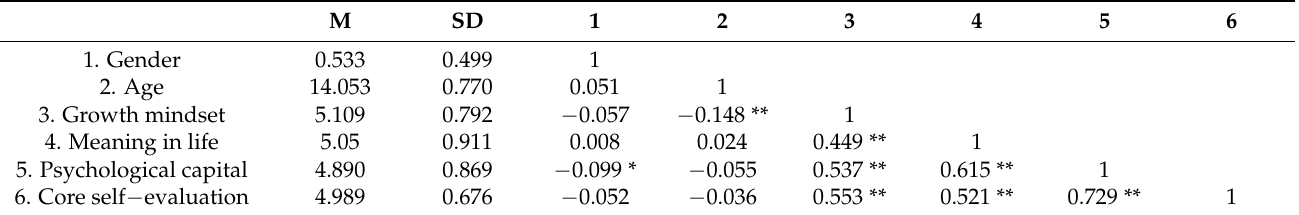
Table 1. The mean, standard deviation, and correlation of the study